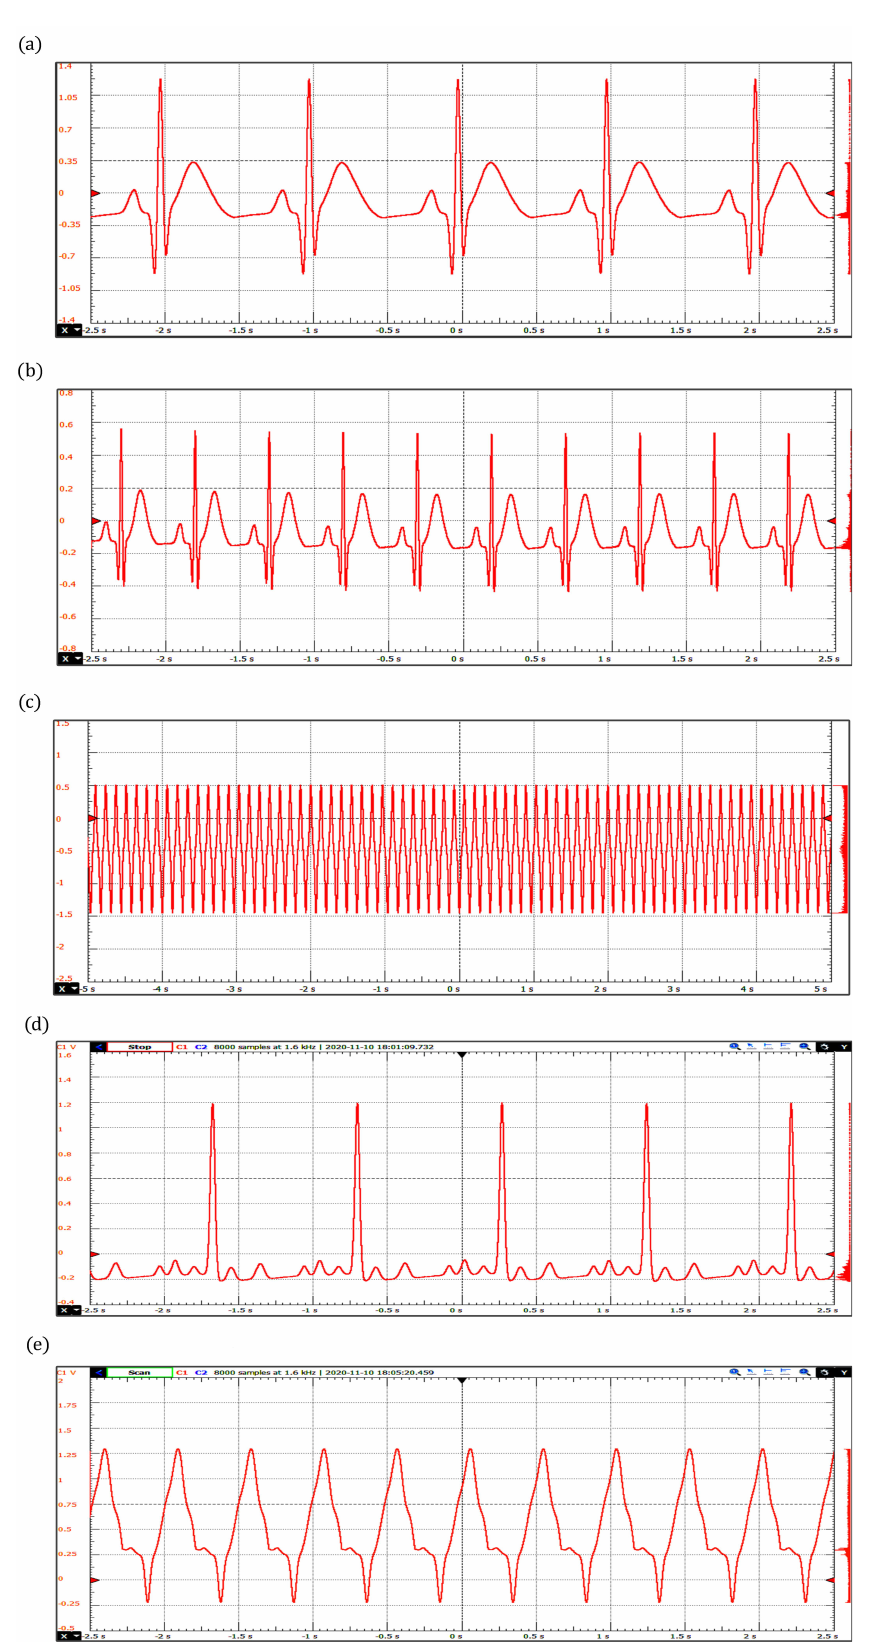
Figure 8. ECG waveforms obtained with the extended dynamical model based on a quasi-periodic motion: ( a ) Bradycardia, ( b ) Tachycardia, ( c ) Ventricular Flutter, ( d ) Atrial Fibrillation, and ( e ) Ven- tricular